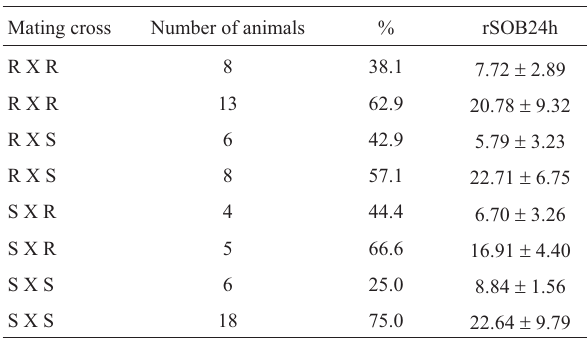
Table 2 - Number and percentage of resistant animals and the extent of intracellular growth of B. abortus in vitro after 24 h (rSOB24h) for each cross indicated.